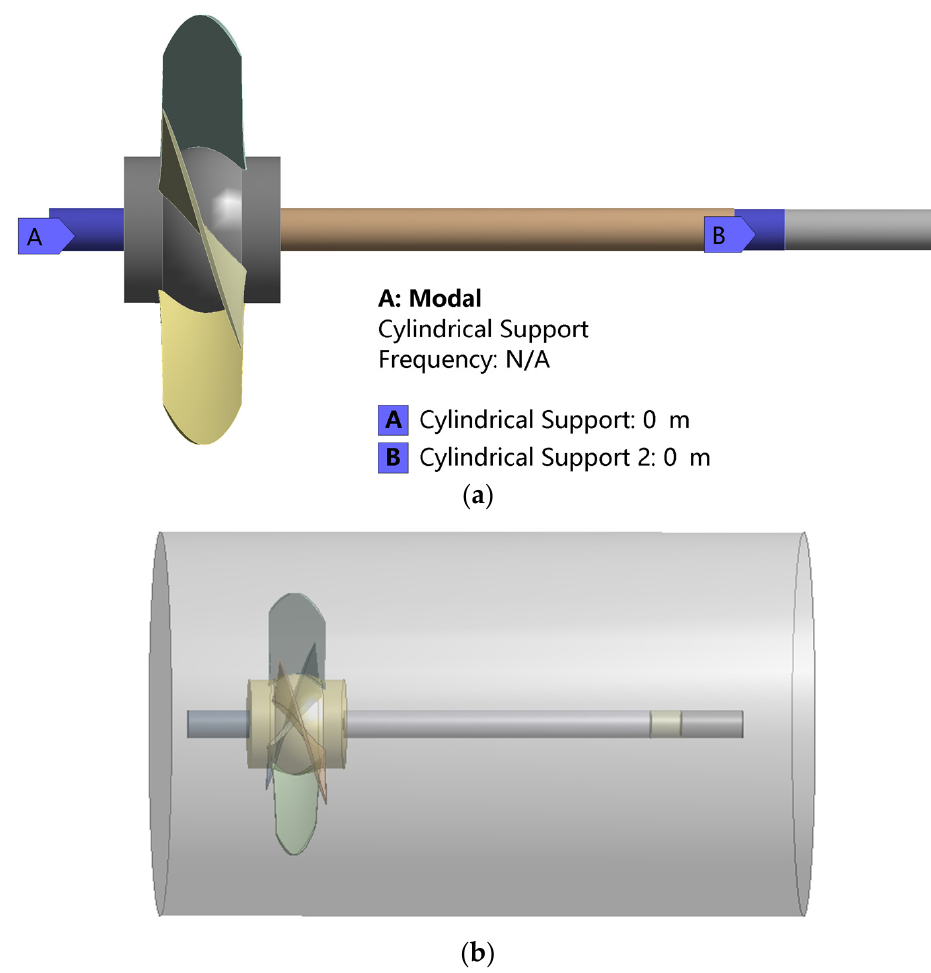
Figure 5. ( a ) Setup of dry modal analysis. ( b ) Setup of wet modal analysis.